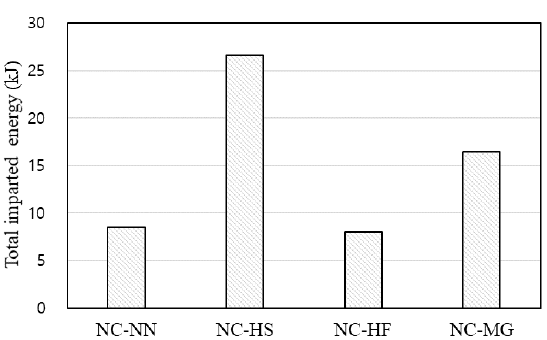
Figure 12. Maximum reaction force.